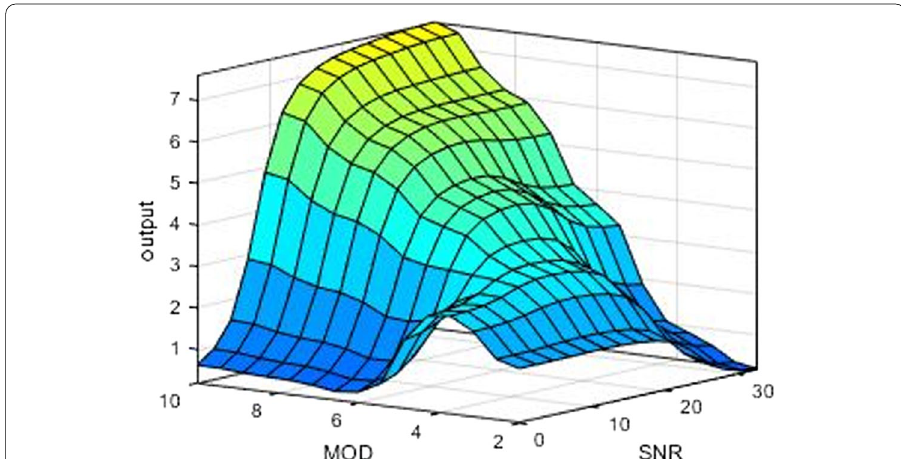
Fig. 24 ANFIS surface view for SNR versus Modulation. This figure shows the 3D ANFIS surface views of the signal-to-noise ratio and different QAM modulation schemes combination result. The upper yellow surface indicates a better data rate resulted from a high SNR value at higher order QAM modulation schemes. The surface with blue color indicates a low data rate resulted from a low order QAM modulation schemes for a range of SNR